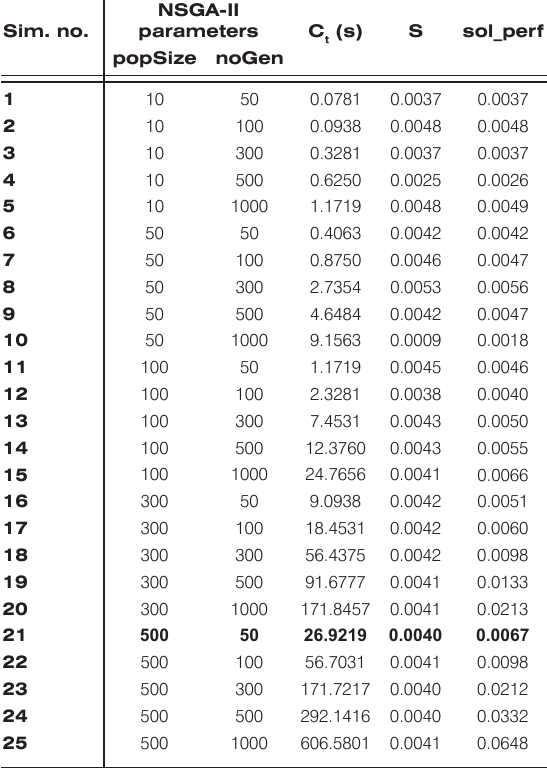
Table 10 contains the values obtained for the set coverage metric along with the best value for the jumping genes probability, highlighted in bold, in the last line of the table.